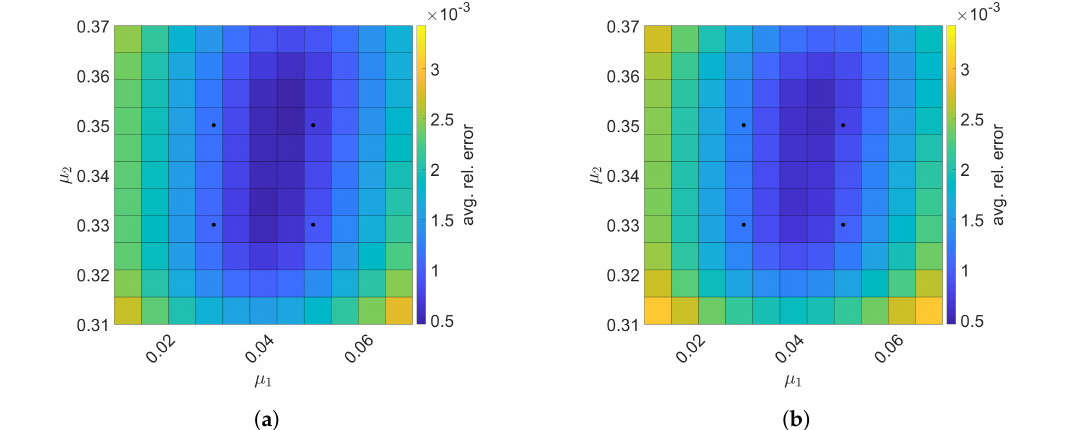
Figure 16. 2D linear convection diffusion equation. The comparison of the Galerkin and LSPG ROMs for predictive cases. The block dots indicate the train parameters. ( a ): Galerkin, ( b ):